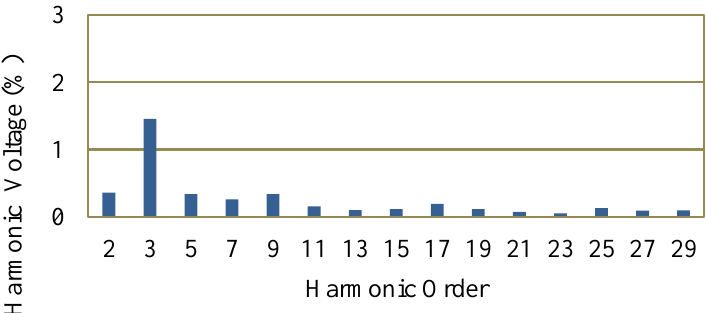
Figure 22. Voltage harmonic distribution at 100% load.